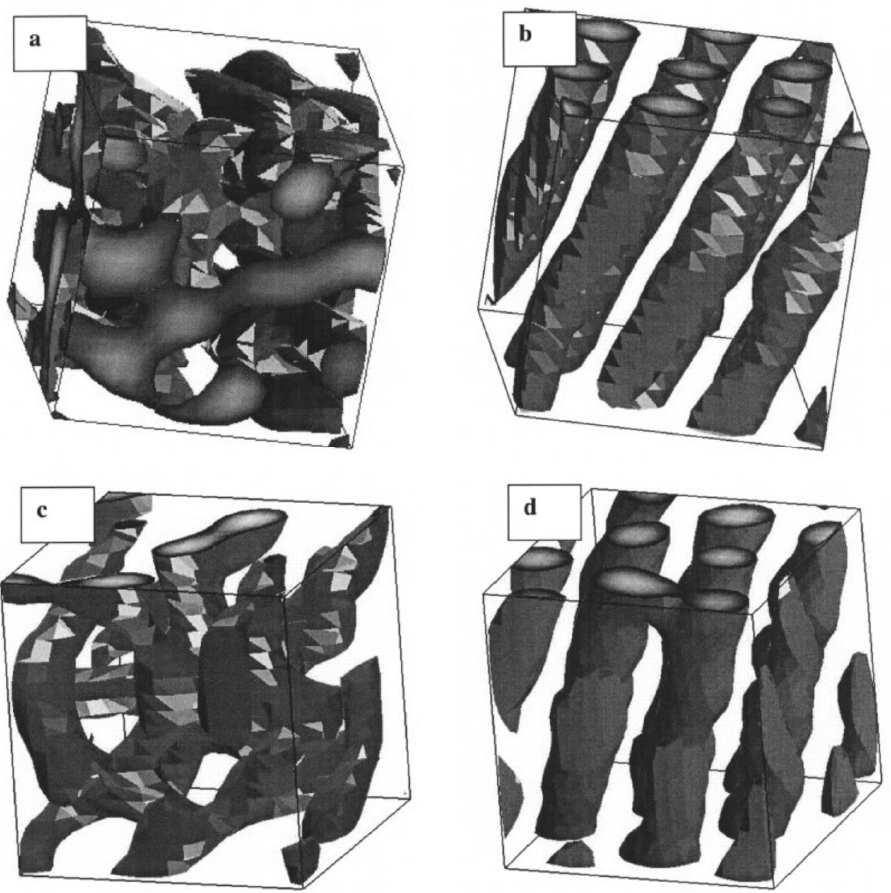
Figure 7. Morphological evolution of hexagonal cylinder phase obtained using DPD and soft BD simulations with N = 27,000, f A = 0.3 and r = 3.0 r c − 3 . ( a ) Interconnected tube structure obtained using DPD with t = 1000 τ and ( χ N ) eff = 23.7. ( b ) Hexagonal cylinder phase obtained using DPD with t = 30 000 τ and ( χ N ) eff = 23.7. ( c ) Interconnected tube structure obtained using soft BD with t = 1000 τ and ( χ N ) eff = 23.7. ( d ) Hexagonal cylinder phase obtained using soft BD with t = 150,000 τ and ( χ N ) eff = 23.7. (Copyright J. Chem. Phys. ,